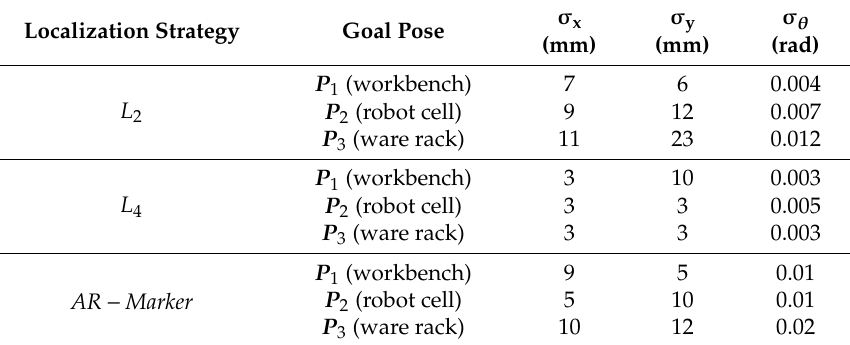
Table 4. Positioning accuracy of autonomous navigation.